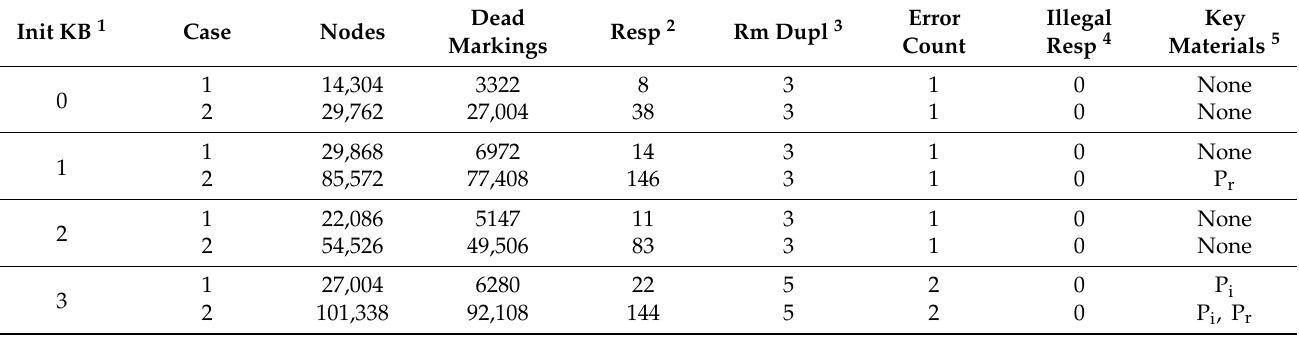
Table 4. Results of Model